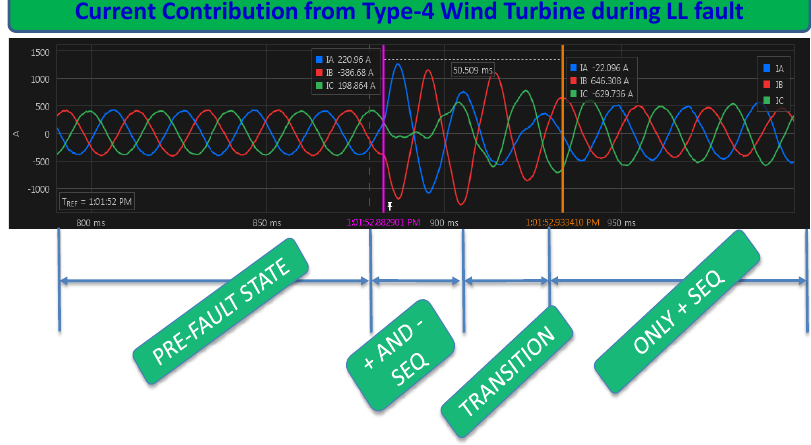
Figure5. Figure 5. Fault contribution from Type 4 WT with negative sequence current suppression strategy [23,24].